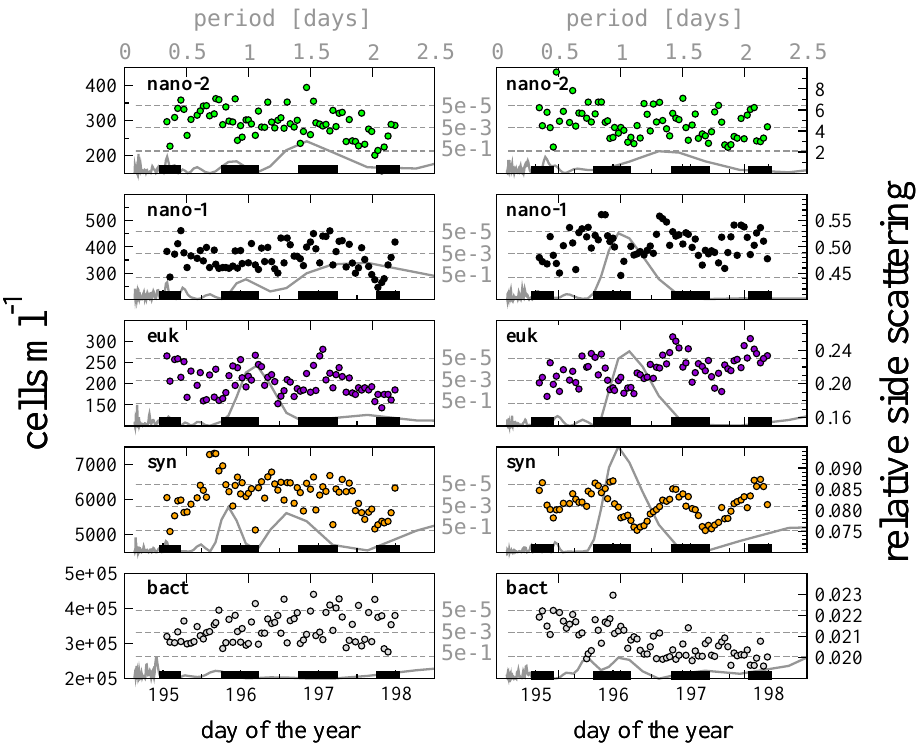
Fig. 2. Time series of flow cytometric estimates of cell abundance (left column) and side scattering relative to 1µm beads (right column). Black bars on the x-axes indicate the night-time periods. Solid grey lines are Lomb-Scargle periodograms of each time series plotted as a function of period (upper x-axis). Horizontal dashed grey lines are three significance levels (0.5, 0.005, 5e-5) for the periodogram peaks. Prochlorococcus was not reliably detected by the instrument used for the